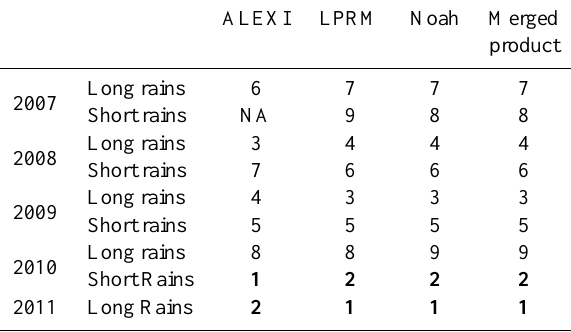
Numbers in bold indicate the 2010–2011